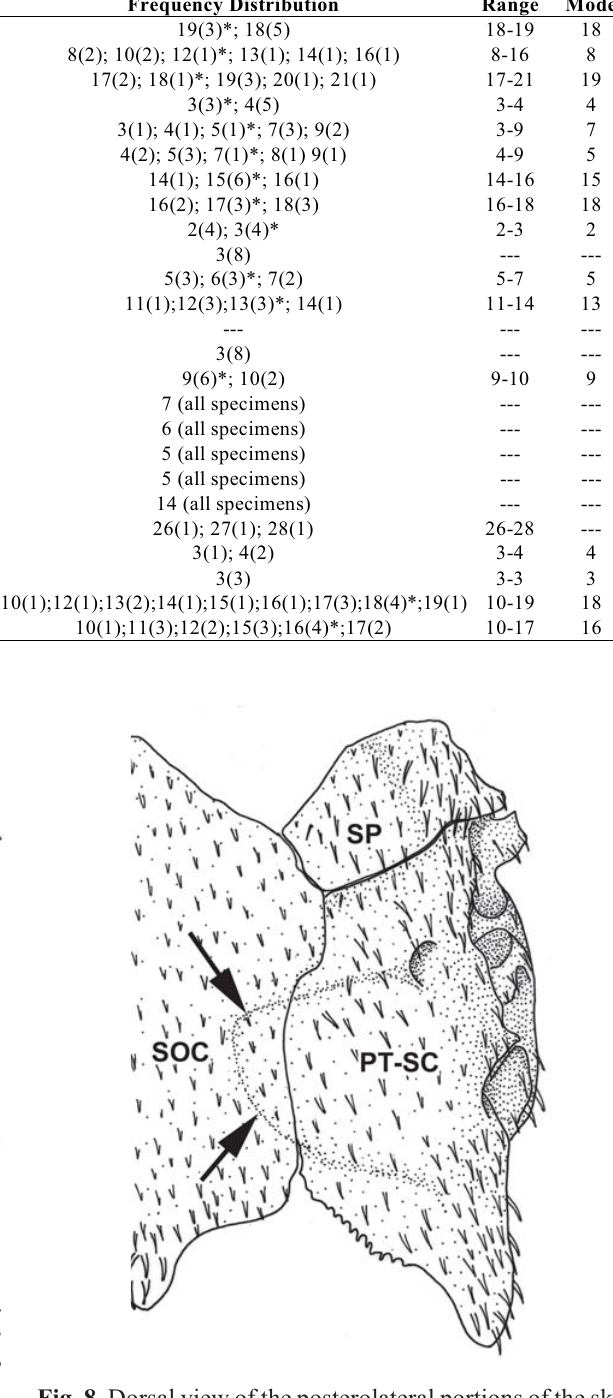
Fig. 8. Dorsal view of the posterolateral portions of the skull of Otothyropsis marapoama, Paratype, LIRP 5641, 29.0 mm SL. Arrows indicate the internal limits of the swimbladder capsule seen by transparency in c&s specimens. Note that supraoccipital contributes to dorsal wall of swimbladder cap- sule. Anterior at